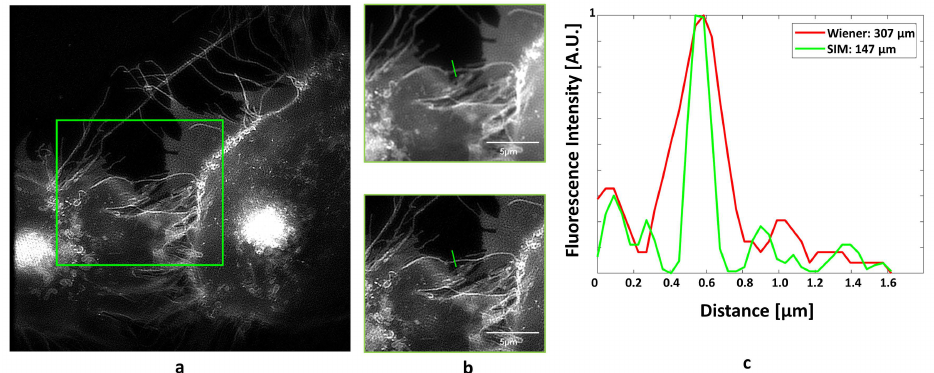
Figure 3. Fluorescence image of CHO-K1-hIR-myc-GLUT4-GFP cells upon stimulation by insulin (1 µ M; 60 min): ( a ) Wide-field microscopy with Wiener filter; ( b ) comparison of filtered wide-field (upper part) and super-resolution microscopy by (coherent) structured illumination (SR-SIM) (lower part) for a selected field; ( c ) line scan with Gaussian fit over a marked range of 0.8 µ m across the plasma membrane for filtered wide-field and SIM; excitation wavelength: λ 0 = 488 nm; detection range: λ D 515 nm; Plan Neofluar 40 /1.30 oil immersion objective lens. ≥ ×